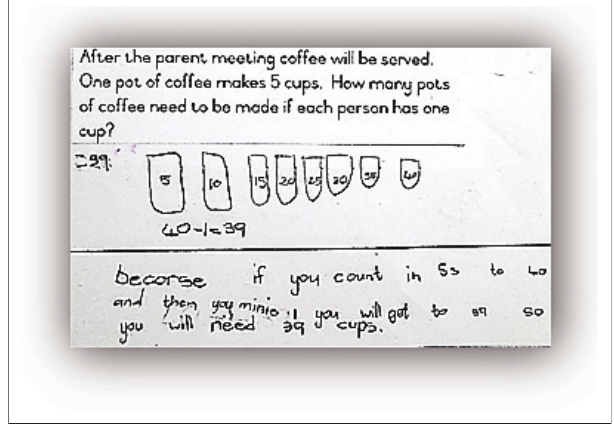
FIGURE 7: Jarred